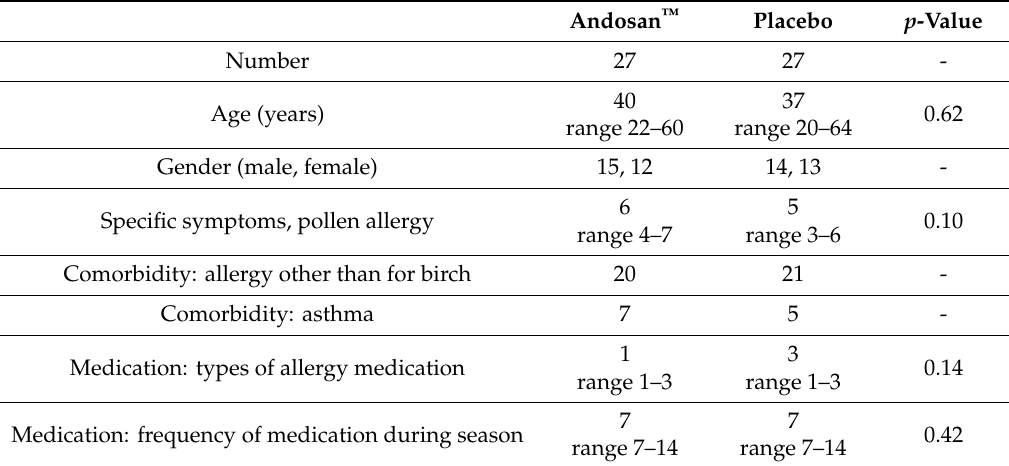
Table 1. Demographic and blood donor